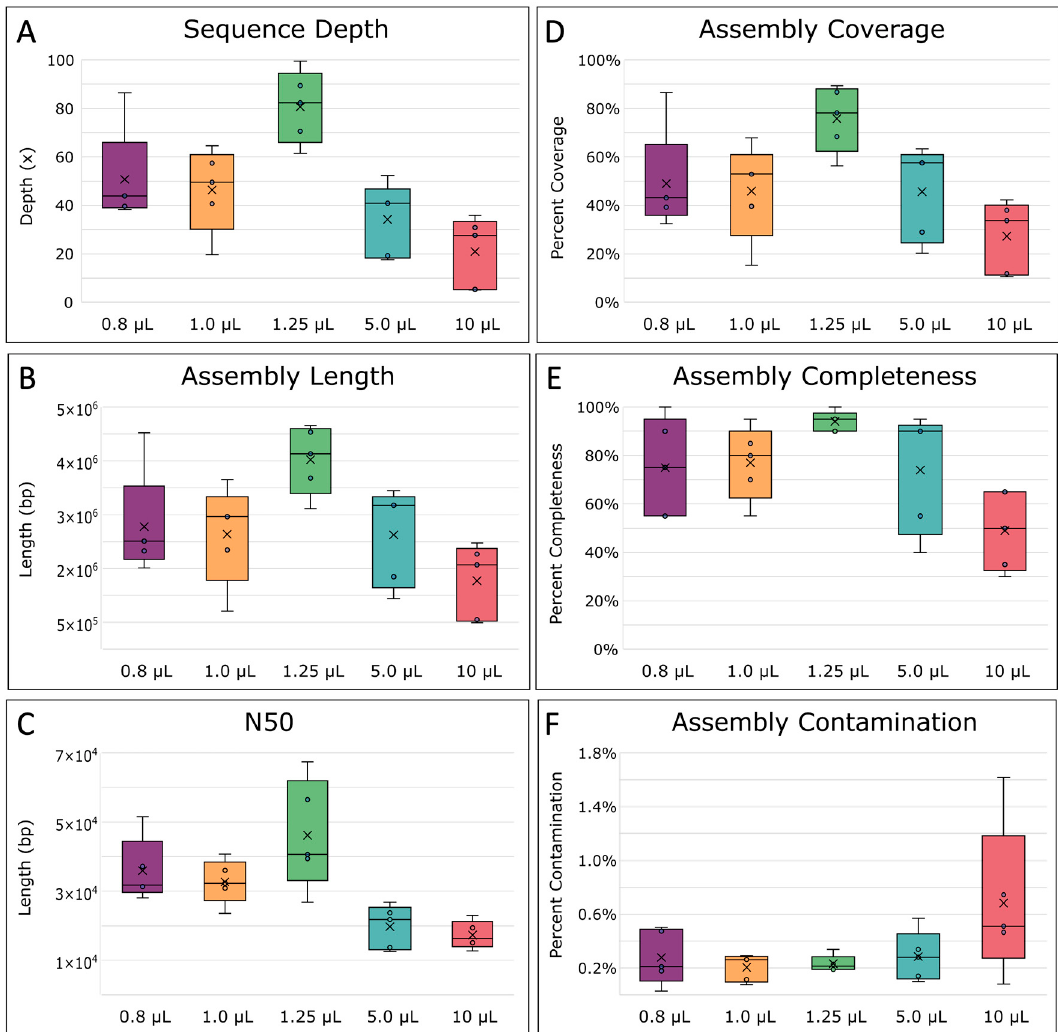
Figure 6. Single-amplified genome (SAG) assembly statistics. ( A ) Final sequence depth, calculated as the estimated number of times each base within the genome was sequenced on average. ( B ) The total average length of the assemblies, ( C ) N50 average, the minimum contig length needed to support 50% of the genome assembly, and ( D ) the percent coverage of the assemblies across the E. coli MG1655 reference genome, were all determined with QUAST [70]. ( E ) The completeness of the assembled genome and ( F ) percent of contaminated bases in the assemblies, were determined by MDMCleaner [12]. The boxes’ middle line represents the median, and the x represents the mean. Five replicates were used for calculation.